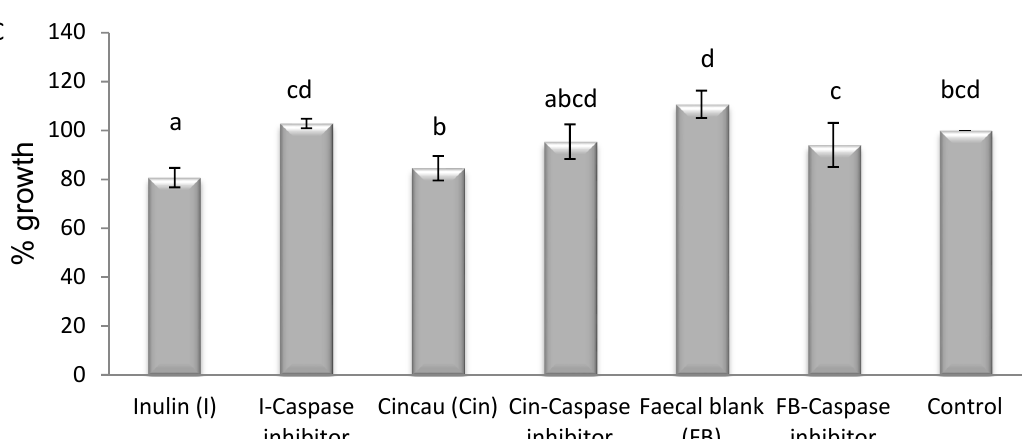
are SEM of three independent experiments performed in triplicates. Data points denoted by different superscripts (letters above the bar) differ significantly with p < 0.05. LU, Luminescence units; FU, fluorescence units